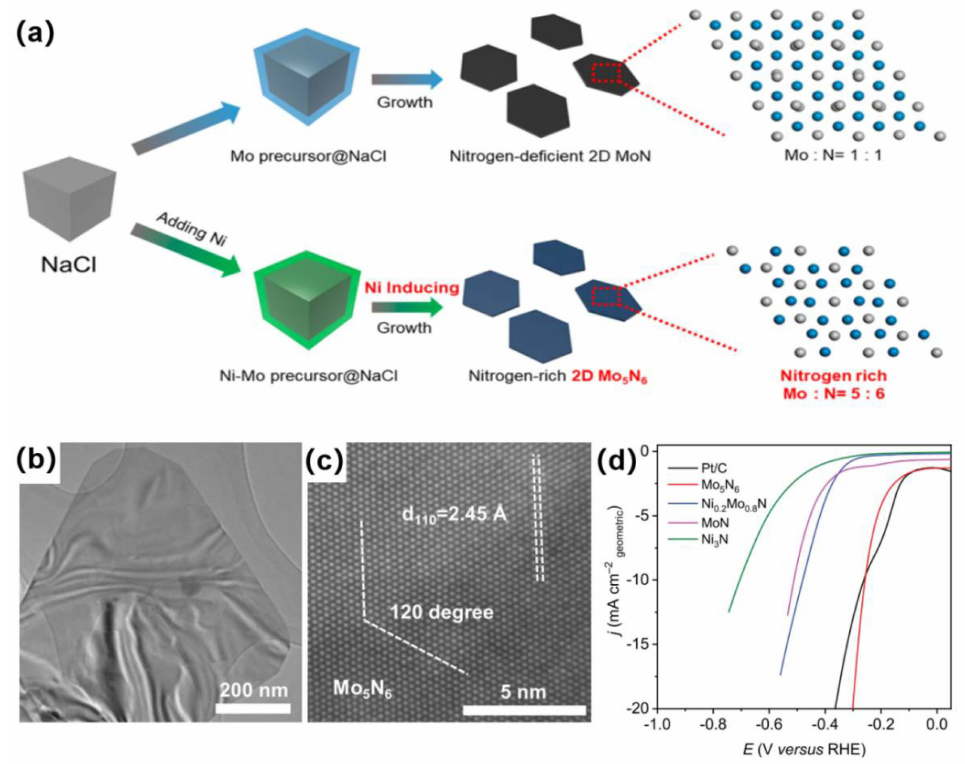
Figure 10. ( a ) Schematic diagram of the synthesis of MoN and Mo 5 N 6 nanosheets, ( b ) low-resolution TEM image, ( c ) high-resolution STEM image of Mo 5 N 6 , and ( d ) LSV curves of different types of catalysts measured in Ar-saturated natural seawater. Reproduced with permission from